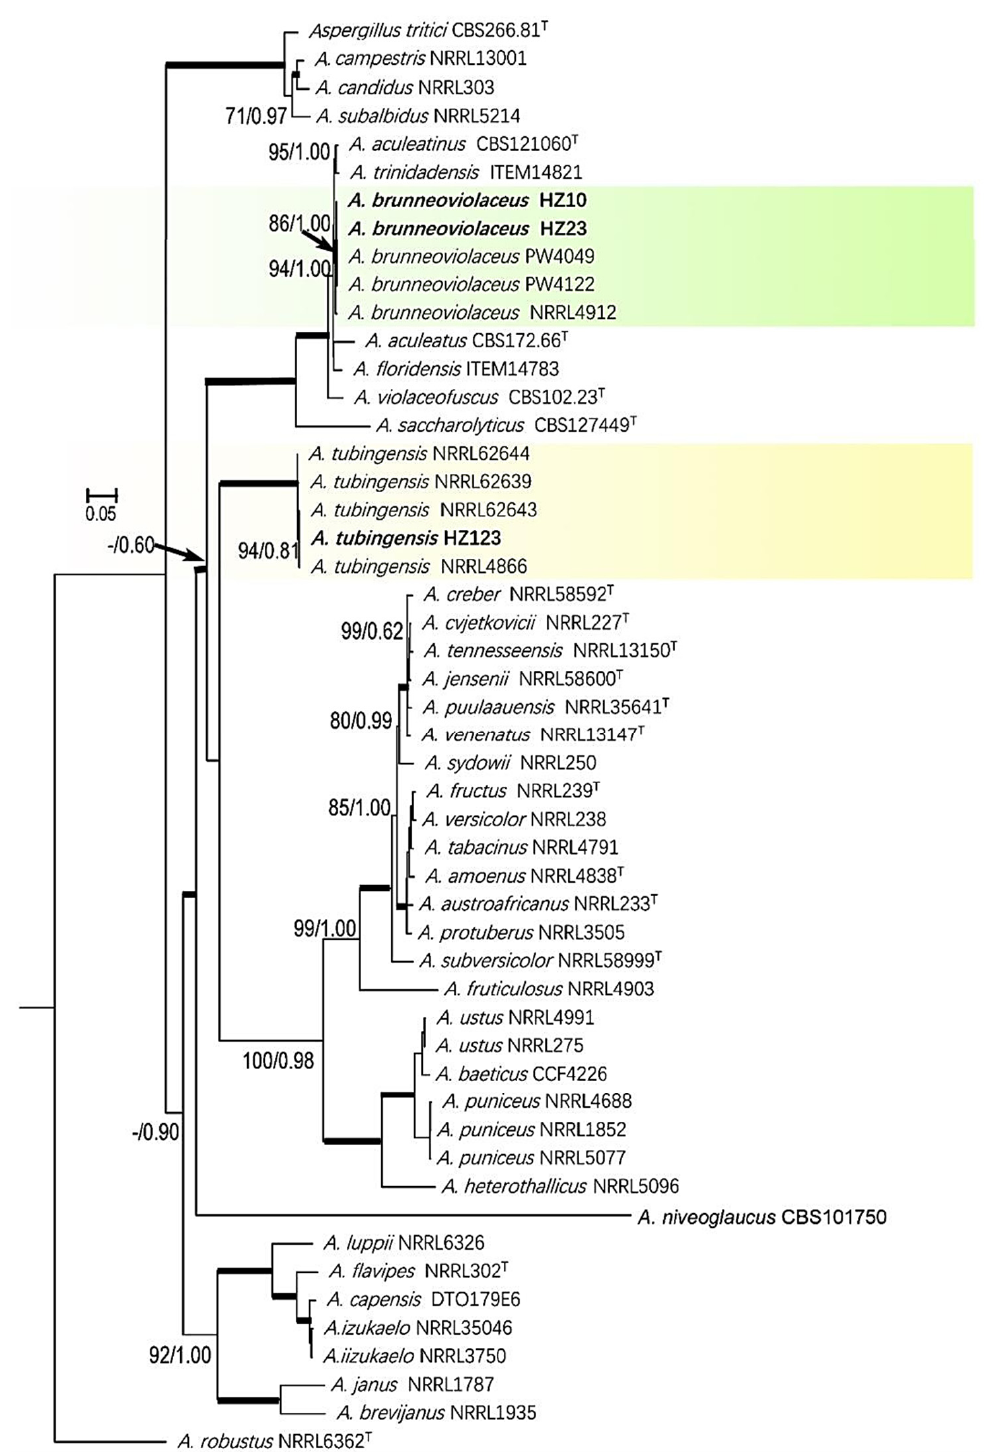
Figure 8. Maximum likelihood (ML) tree generated from the combined ITS region and TUB, RPB2, and CaM sequences of 52 taxa of Aspergillus . The tree is rooted with A. robstus NRRL6362 T . Clades with 100% ML bootstrap support and 1.00 Bayesian posterior probabilities (BPP) are indicated by thick black lines. Clades with >80% ML-BS (left) and 0.95 BPP (right) are indicated by the corresponding support values. Dashes indicate support values lower than 80% ML-BS and 0.95 BPP. Species isolated from soil are shown in bold. T: type